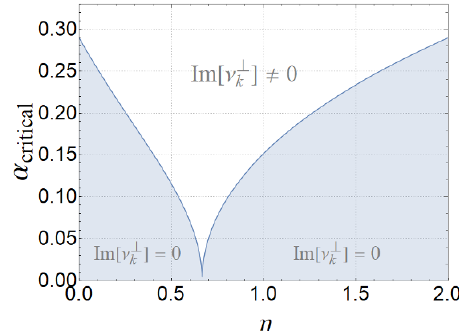
Figure 3. This (cid:12)gure shows the regions of stability and instability in the transverse channel for various values of (cid:17) . The shaded region is stable, while the unshaded region where Im[ (cid:23) ? indicates an